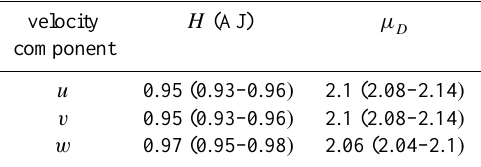
Table 2. Diffusion scaling H of the AJ rule and complexity index µ for each velocity component. The values of µ D from the diffusion scaling H under the renewal assumption, i.e. by inverting Eq. (17). The average and the range of fitted ( H ) and computed ( µ ) values are D